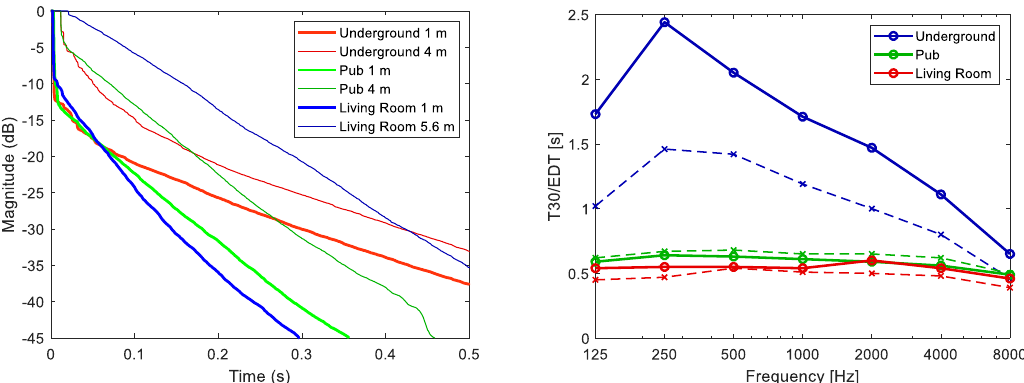
Figure 6. EDCs (left panel) for the three environments and distances (1.00 m, thick; 4.00 or 5.60 m, thin) as in Figure 5 and Table 1. In addition, reverberation times (T30, solid lines) and early decay times (dashed lines) per octave band averaged over all loudspeaker and receiver positions for the three environments are shown in the right panel. These estimates are comparable to the broadband estimates provided in Table